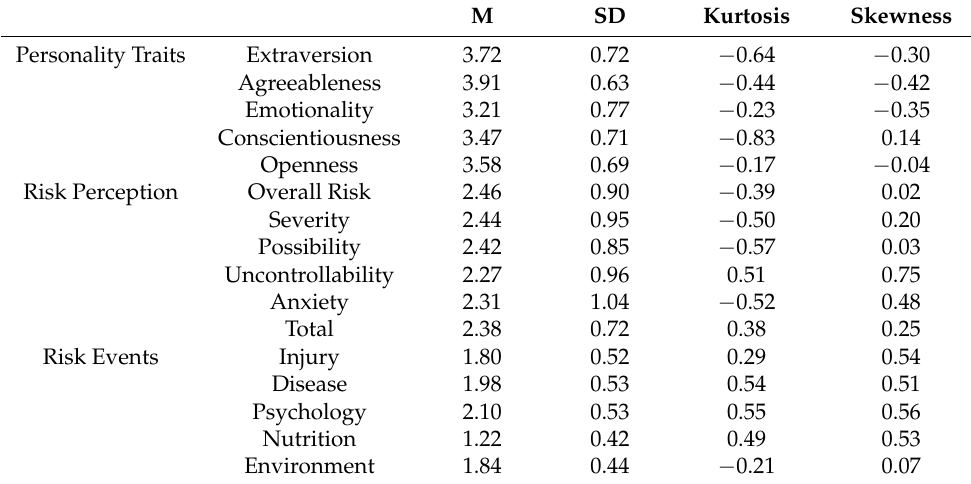
Table 2. Descriptive statistics for all included variables ( n = 664). M SD Kurtosis Skewness Personality Traits